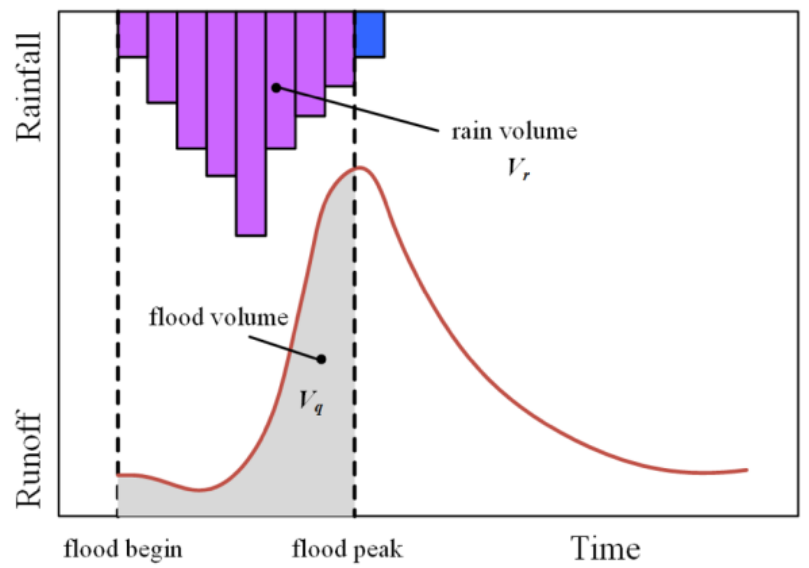
Figure 1. Schematic diagram of the rainfall–runoff process. V r and V q are the rainfall volume and runoff volume for the period before flood peak, respectively.